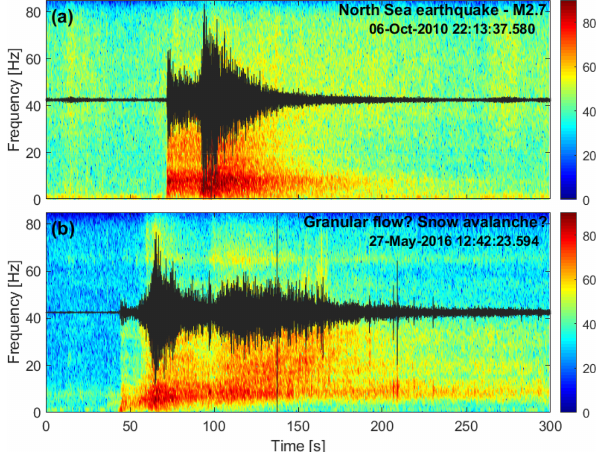
Figure 11. Vertical component records and spectrograms recorded on the broadband seismometer (AKN) showing (a) a M 2 . 7 earth- quake located in the North Sea and (b) an avalanche in late spring 2016, which destroyed the cable to geophone 2. Data are band-pass- filtered in the range